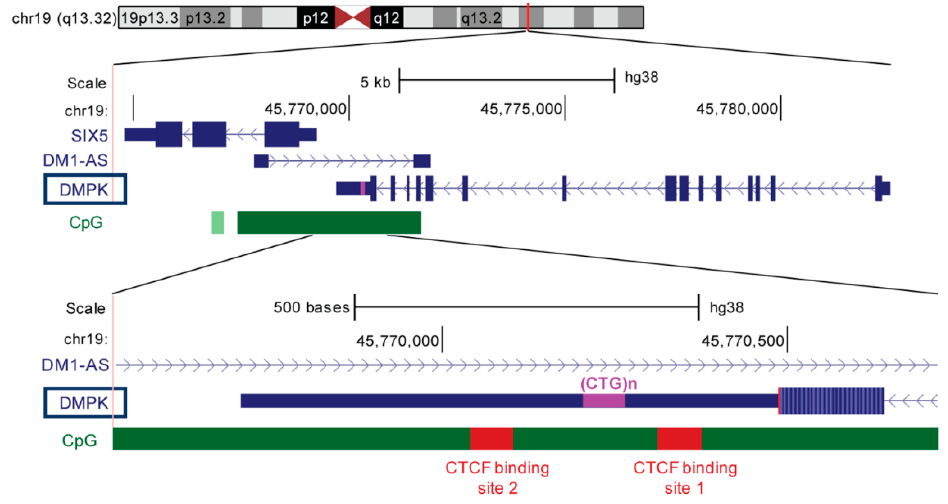
Figure 1. Annotation view of the 19q13.32 genomic region adapted from the UCSC genomic browser (https://genome.ucsc.edu/, accessed on 29 October 2021). CTG repeats (pink rectangle) are located in the 3 ′ untranslated region of the DMPK gene (exons—blue rectangles, introns—blue lines, 5 ′ and 3 ′ untranslated regions—thinner rectangles, direction of transcription—indicated by arrowheads on the introns). The CpG island (green rectangle) encompasses the 3 ′ end of the DMPK gene, the DM1-AS gene and the 5 ′ end of the SIX5 gene. The CpG island contains two binding sites for the CTCF protein, one upstream (CTCF1) and one downstream (CTCF2) of the CTG repeats (their relative position is indicated with regard to CTG repeats).